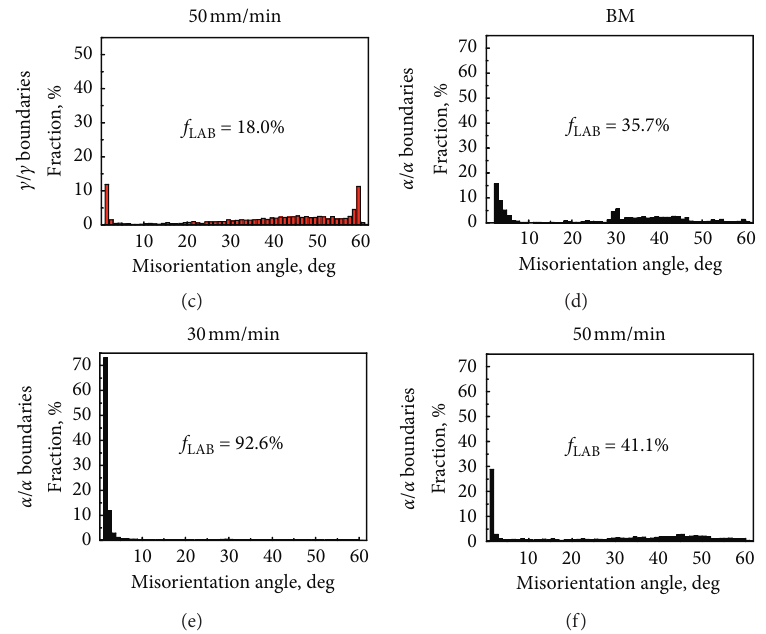
Figure 4: Statistics of grain boundary misorientation angle distributions of base material and stir zones at different welding